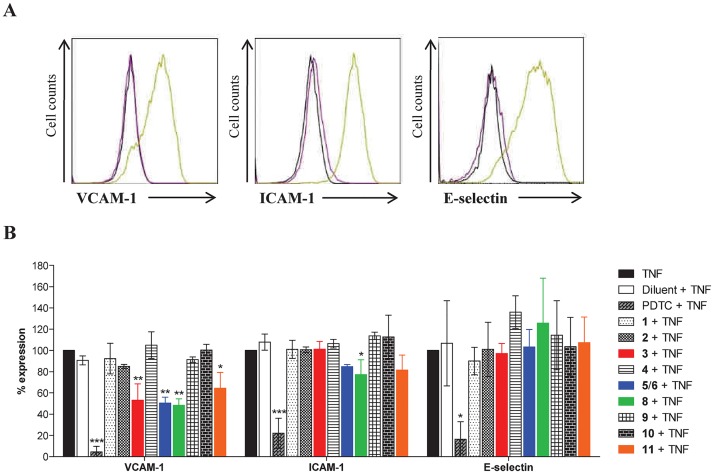
Effect of compounds 1–6 and 8–11 on TNF-induced expression of inflammatory molecules in ECs.(A) Basal versus TNF-induced expression of VCAM-1, ICAM-1 and E-selectin after 6h of incubation. Data shown are representative histograms from fluorescence-activated cell sorting (Facs) analysis showing constitutive versus induced expression of inflammatory molecules (VCAM-1, ICAM-1, E-selectin) at the cell surface of ECs. Histograms show the intensity of fluorescence (log, x-axis) versus cell number (y-axis) for untreated (purple line) and cytokine-treated (green line) ECs analyzed by flow cytometry. Immunostaining using an irrelevant isotype-matched IgG (dark line) was used as a negative control. (B) Inhibitory effects of NPs. Expression of VCAM-1, ICAM-1 and E-selectin was measured by Facs. Each bar represents geometric mean ± SD of fluorescence intensity calculated from three to five independent experiments. Statistical analysis was performed using Kruskal-Wallis test with Dunn’s post-test; *p < 0.05, **p < 0.01, ***p < 0.001 compared with TNF control group. PDTC (200 μM) was used as a positive control for inhibition.